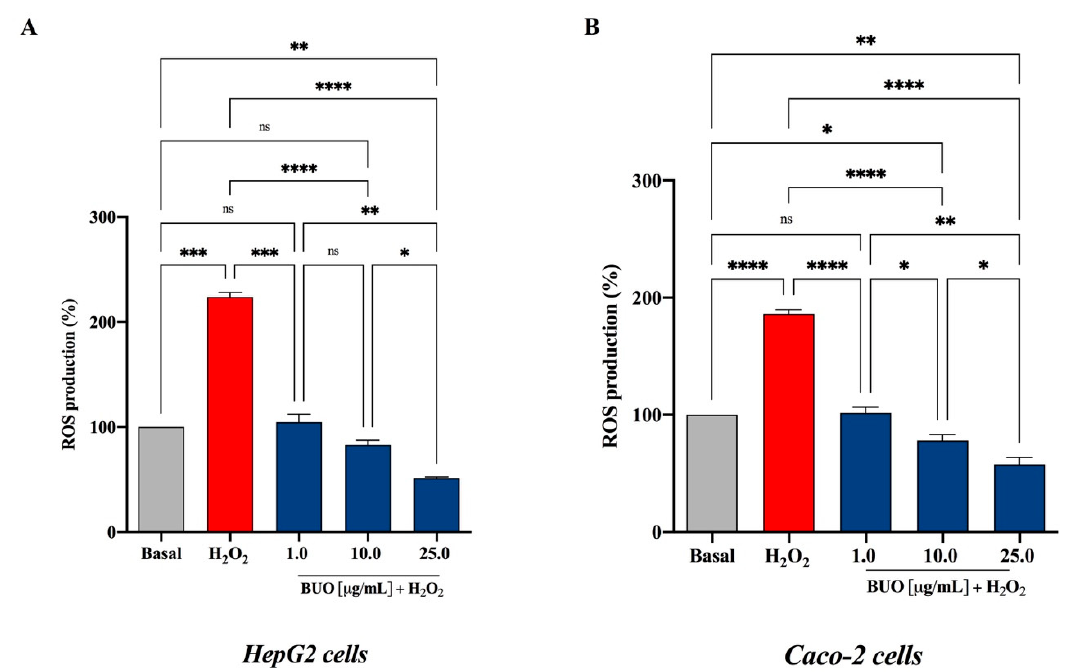
Figure 3. Evaluation of the effects of the BUO extracts on H 2 O 2 -induced reactive oxygen species (ROS) production levels in human hepatic HepG2 ( A ) and intestinal Caco-2 ( B ) cells. The data points represent the averages ± SD of six independent experiments in duplicate. Basal vs. H 2 O 2 samples were analyzed by t-student test, whereas All data sets were analyzed by One-way ANOVA followed by Tukey’s post-hoc test. ns: not significant; (*) p < 0.5; (**) p < 0.01; (***) p < 0.001; (****) p < 0.0001. Basal: untreated cells.